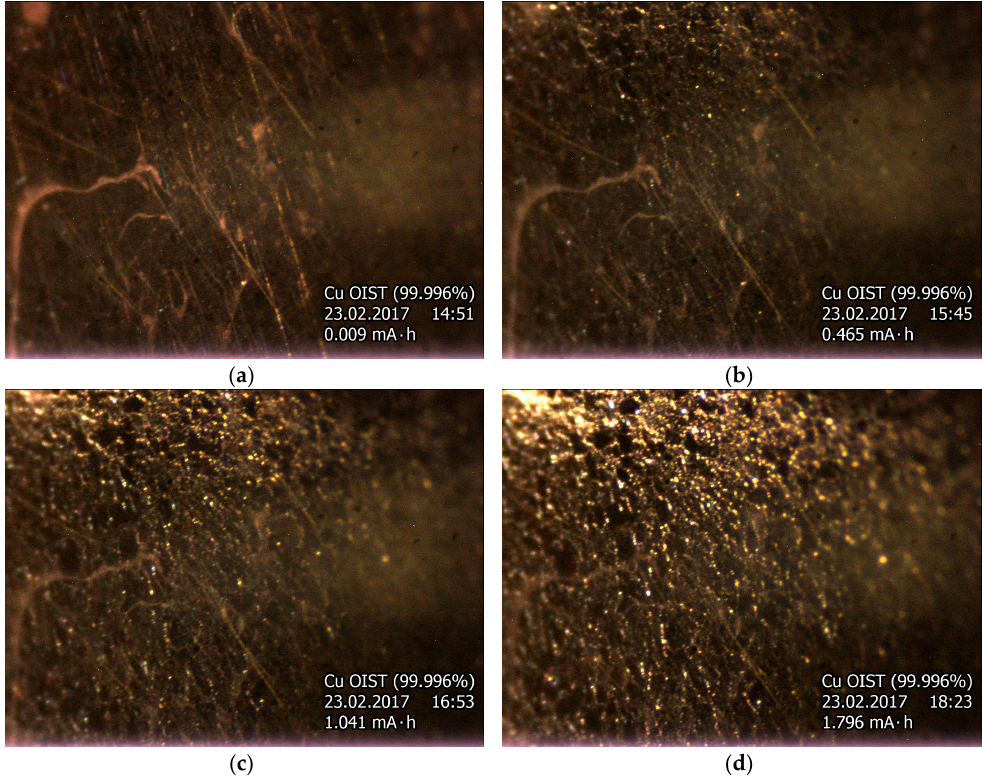
Figure 3. Images of the surface of 99.996% fine copper irradiation by a 2-MeV proton beam with varying integrals of the current: ( a ) 0.009; ( b ) 0.465; ( c ) 1.041; ( d ) 1.796 mA·h. The frame size is 9 mm horizontally and 4 mm vertically.